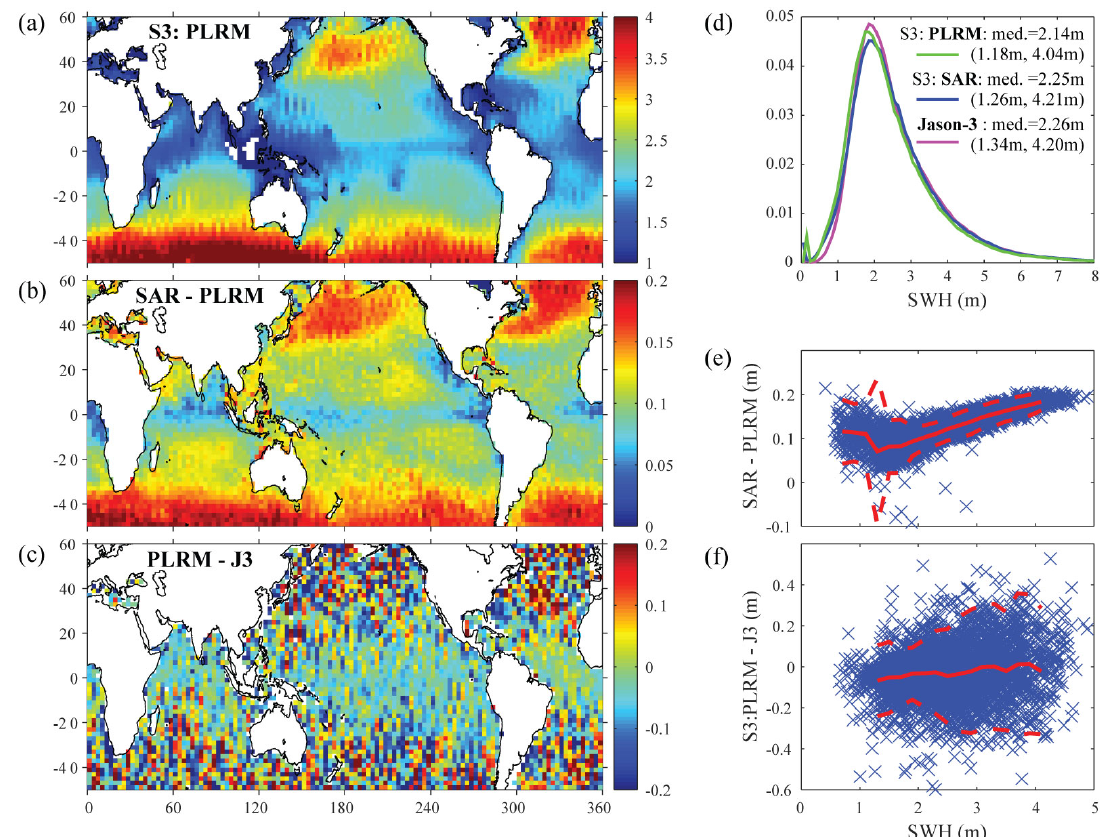
Figure 18. Comparison of altimeter SWH data for 2019. ( a ) Average of all 2019 for Sentinel-3 PLRM data ( b ) Mean bias of Sentinel-3 SAR mode data to those from PLRM ( c ) Difference of mean fields from S3:PLRM and Jason-3 (LRM) ( d ) Probability distribution functions of SWH data for Jan. 2019. Numerical values are the median and (in brackets) the 10th and 90th percentiles. Data are limited to 50 ◦ S to 60 ◦ N to avoid effects of undetected sea-ice. Comparison of grid box means for 2019 for ( e ) S3:SAR relative to PLRM and (f) PLRM relative to Jason-3. Full red lines show mean relationship in 0.2 m wide bins with the dashed lines showing ± 2 std. dev. For these last 2 plots some data exist outside the axes shown, but these are relatively